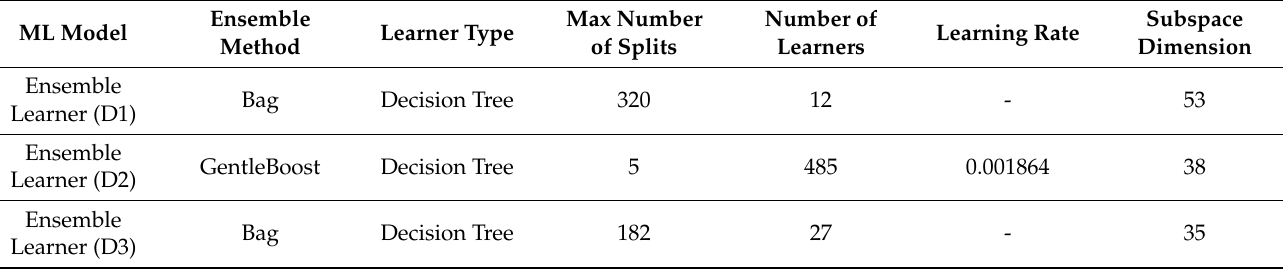
Table A7. Ensemble Learner: optimized hyperparameters for each